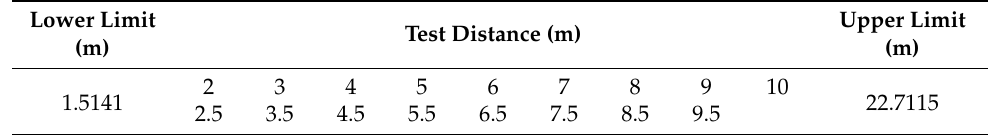
Table 2. The test distance value used in the simulation and experiment. Lower